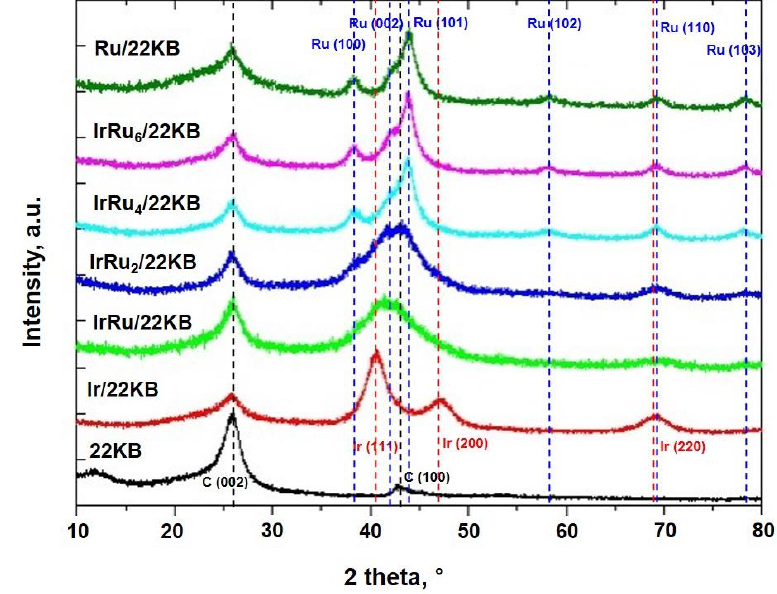
Figure 1. XRD patterns of Ir, IrRu, IrRu 2 , IrRu 4 , IrRu 6 , and Ru supported on 22 KB. The XRD pattern of carbon support 22 KB is also shown for comparison.